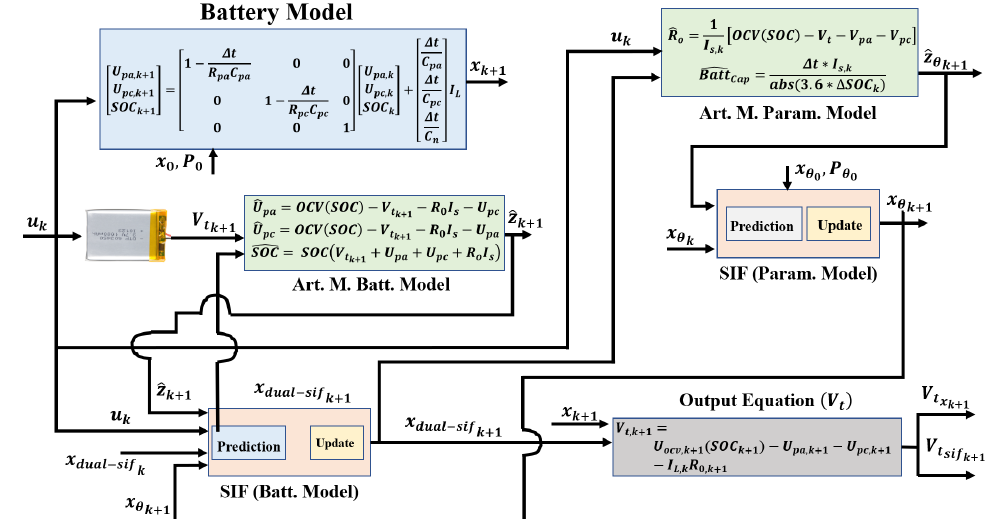
Figure 3. Block diagram of the proposed dual strategy.